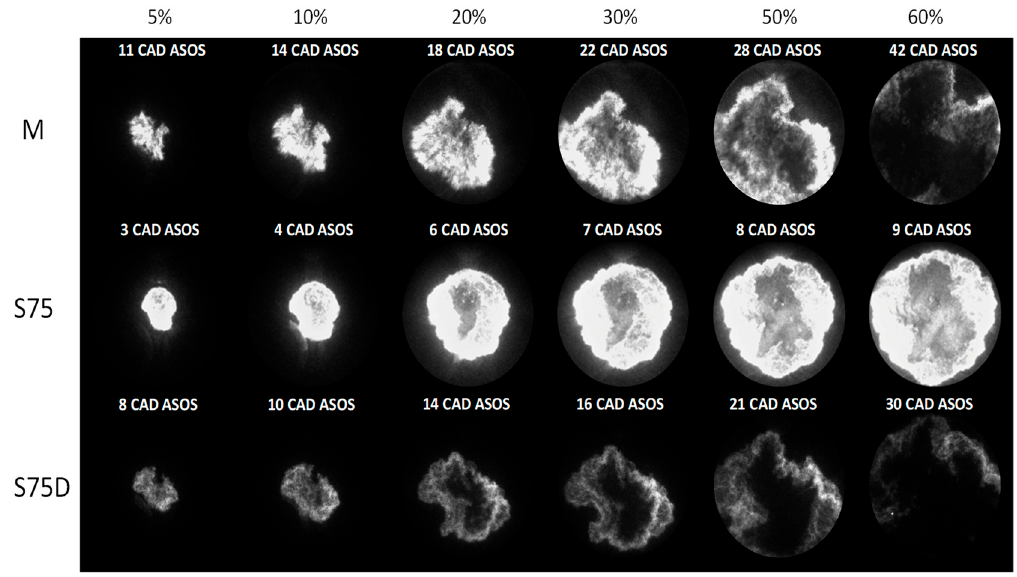
Figure 13. Image sequence of flame evolution at the same flame area (5%, 10%, 20%, 30%, 50% and 60% of the piston area) for a lean air-fuel ratio ( λ = 1.4) with M, S75, and S75D fueling.